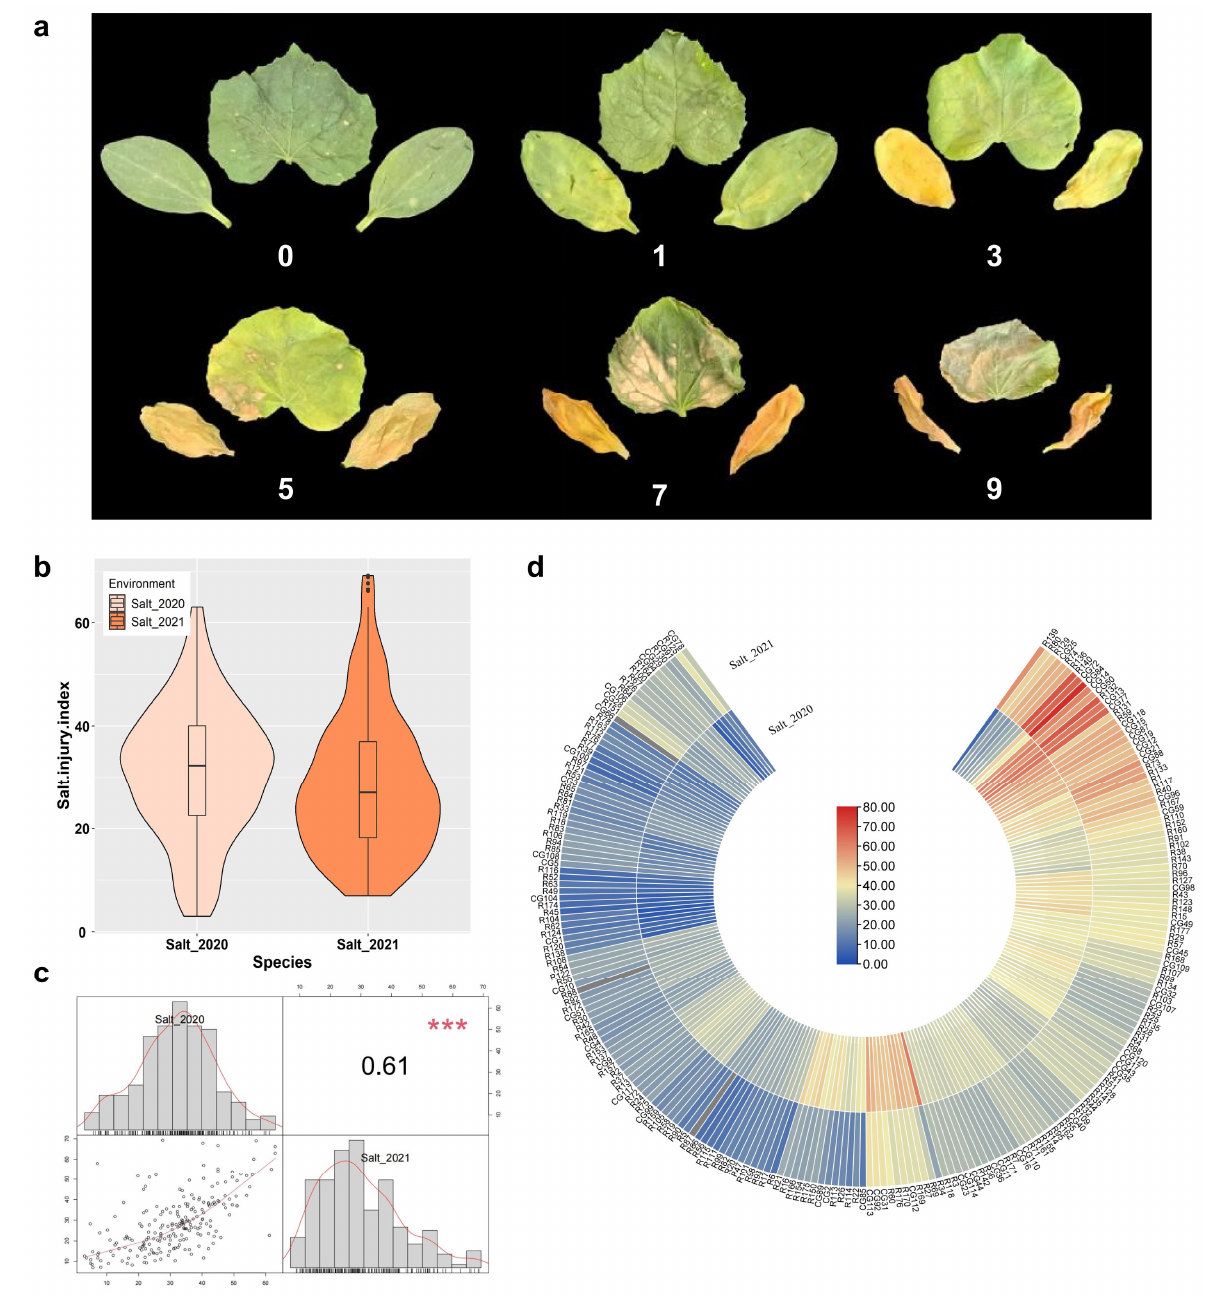
Figure 1. Phenotypic characterization of salt tolerance in 14 day old cucumber seedlings that were treated with 200 mmol · L − 1 NaCl for seven days. A total of three replicates were set for each experiment, with a total of 15 replicates per accession. ( a ) Salt injury of cucumber seedlings was divided into 6 grades. 0, the cotyledons and the first true leaf show no symptoms of salt injury; 1, the cotyledons are slightly yellowed; 3, the cotyledons and the first true leaf are significantly yellowed; 5, the cotyledons are yellowed and wilted, and the first true leaf is significantly yellowed and wilted; 7, the cotyledons are dehydrated, the large areas of first true leaf are yellowed and wilted; 9, both the cotyledons and the first true leaf are yellowed and dehydrated. ( b ) Violin plot depicting the phenotypic distribution of salt injury index in the two treatments. ( c ) Frequency distribution and Pearson rank correlations of the mean salt injury index in two experiments. *** indicate significance at p < 0.001. ( d ) Heatmap depicting the salt injury index in two